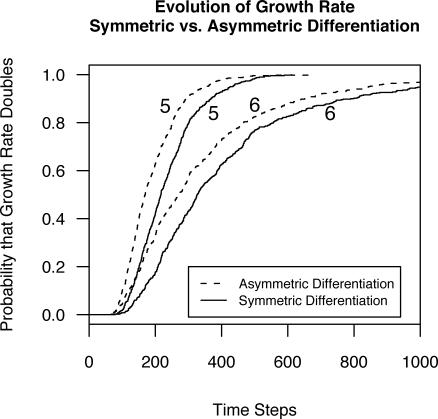
The Probability of Doubling the Population Average Growth Rate as a Function of Time, Asymmetric or Symmetric Differentiation, and Five or Six Differentiation Stages in the ModelsModels with asymmetric differentiation evolve more quickly and are therefore more susceptible to pathologies of somatic evolution (RR = 1.56, 95% CI: 1.41–1.73, p < 0.001).